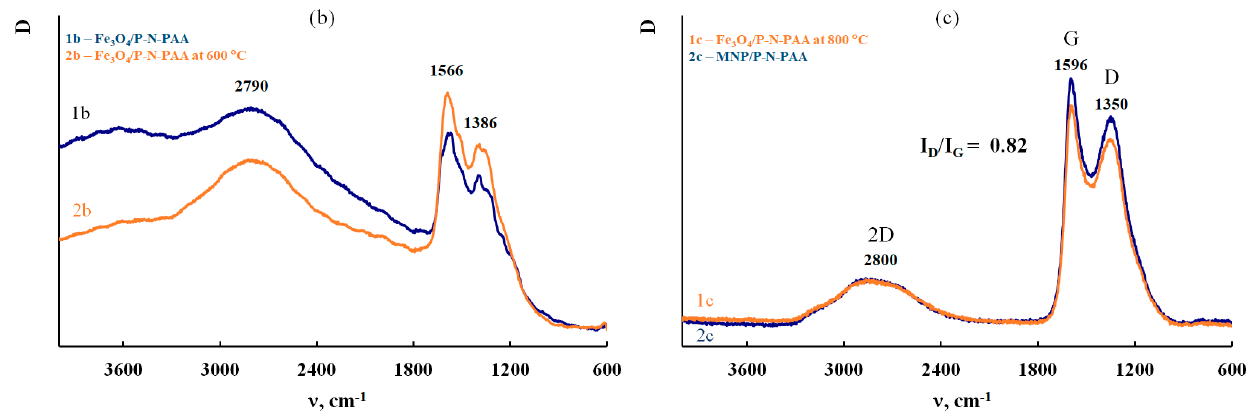
Figure 6. Raman spectra of P ‐ N ‐ PAA ( a ), Fe 3 O 4 /P ‐ N ‐ PAA ( 1b ) and Fe 3 O 4 /P ‐ N ‐ PAA, IR heated at 600 ( 2b ) and 800 °C ( 1c ) and MNP/P ‐ N ‐ PAA ( 2c ).